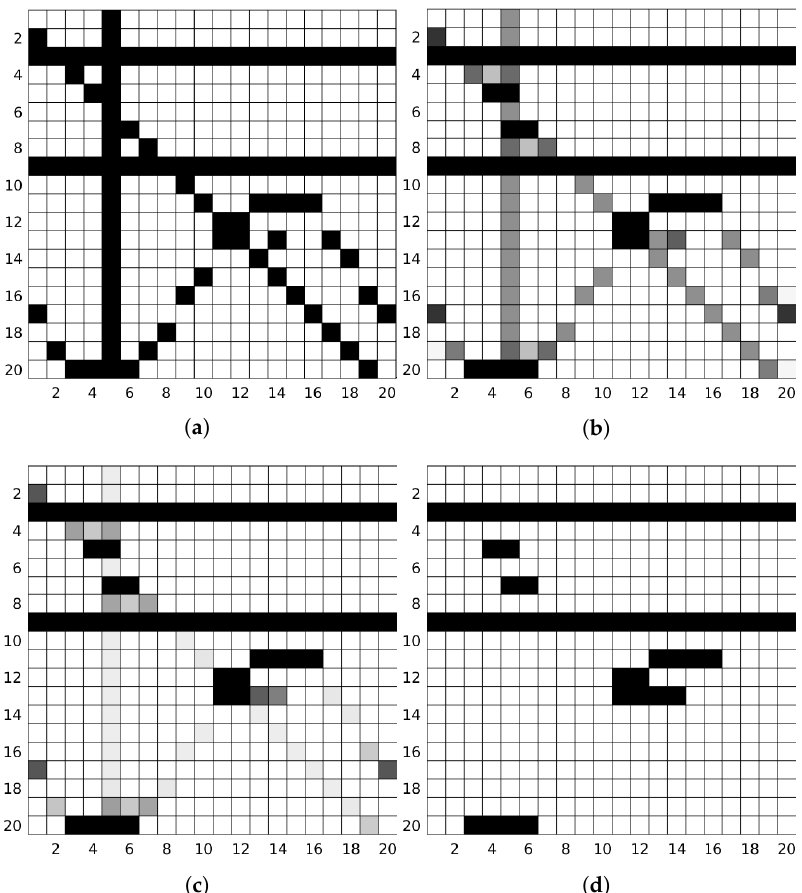
Figure 5. Numerical simulation with MATLAB of a memristor CNN for horizontal line detection. ( a ) Initial image at t = 0; ( b ) snapshot of the transient at t = 0.1; ( c ) snapshot at t = 0.15; ( d ) final image at t = 1.